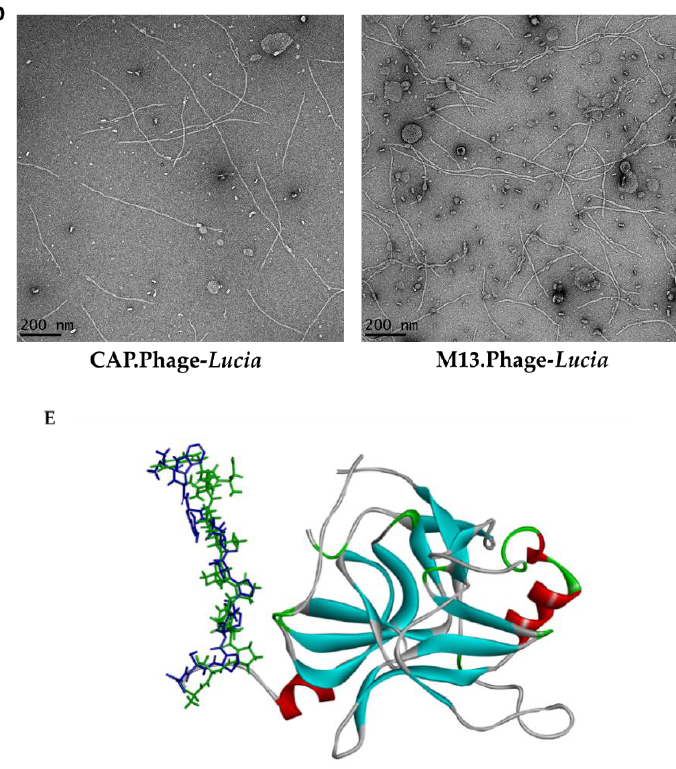
Figure 4. ( A ) Illustration represents targeted CAP.Phage- Lucia gene. ( B ) Stability of phage particles under various pH levels. Phage particles were kept in PBS at pH 3, pH 7, and pH 10 at 4 ◦ C for 24 h ( n = 4). ( C ) Stability of phages at different temperatures. Phage vectors were left in PBS, pH 7, at − 80 ◦ C, − 20 ◦ C, 4 ◦ C, room temperature, and 43 ◦ C for 24 h ( n = 3). Next, phage titers were measured again by E. coli infection followed by colony counting. Results are shown as mean ± SEM. ( D ) Electron microscopic images of bacteriophage-based particles, namely M13.Phage- Lucia and CAP.Phage- Lucia , at 20,000 × magnification. ( E ) Computer modelling of the pIII minor coat protein expressing CAP (green) compared with the free form of CAP (blue).